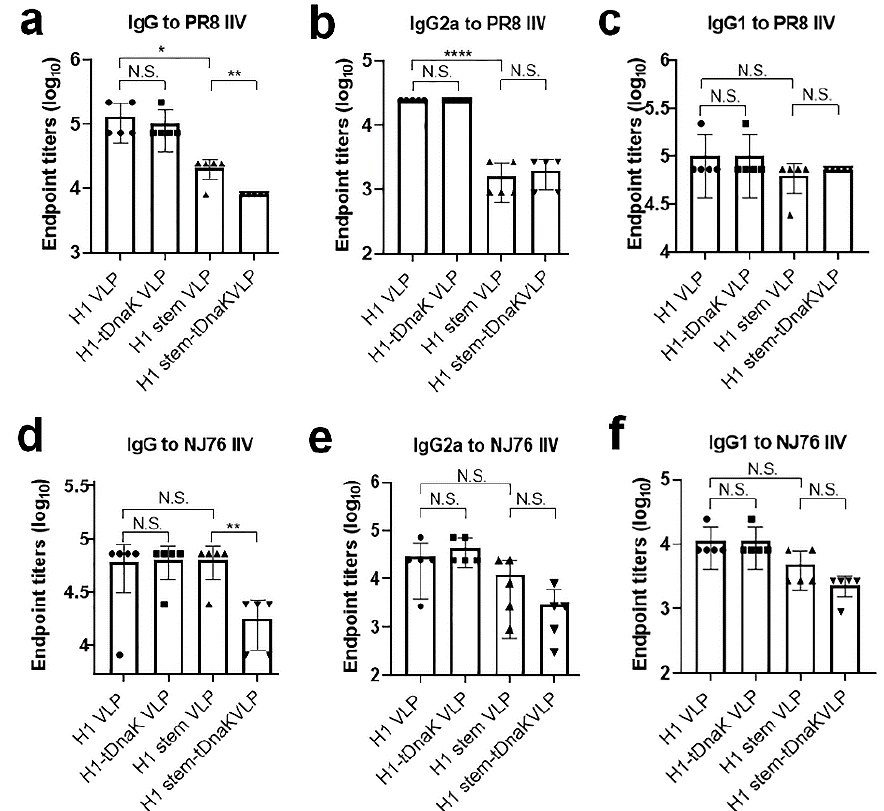
Figure 4. Immunization of mice with the chimeric VLPs’ results in specific serum IgG responses. The error bars represent standard deviations. ( a – c ) PR8-specific and ( d – f ) NJ76-specific serum antibody titers of ( a , d ) total IgG, ( b , e ) IgG2a, and ( c , f ) IgG1 were determined by using ELISA. Antibody endpoint titer is defined as the reciprocal of the highest dilution of a serum that gives a value of OD (450 nm) two-fold above the value of the pre-immune serum negative control. The results are presented as means with standard deviation ( n = 5 per group). Each symbol represents the serum antibody endpoint titer of each mouse. Statistical significance was analyzed by t -test, *, **, and **** represent p < 0.05, p < 0.01, and p < 0.001, respectively. N.S. indicates no significance. Table 2. Virus neutralization titers determination. The highest dilution factors of the diluted heat ‐ inactivated serum that were able to neutralize 150 × TCID 50 of NJ76 or PR8 H1N1 virus are shown in the table.